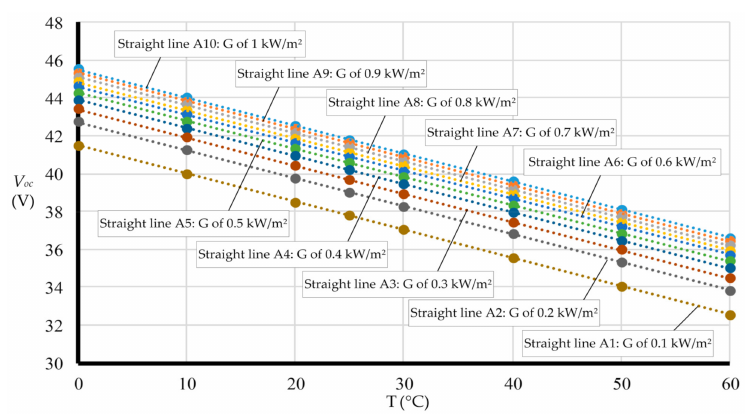
Figure 4. Relationship between V oc , T, and